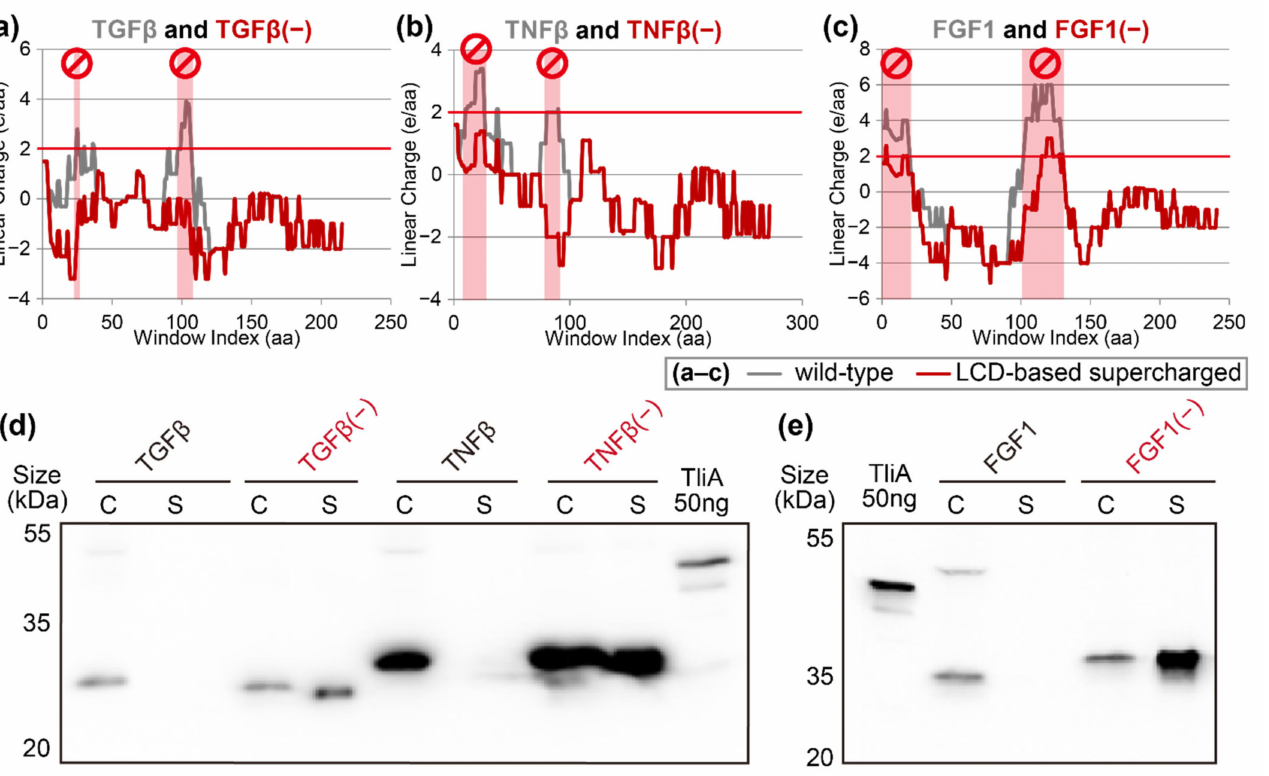
Figure 7. Linear charge density-focused supercharging significantly improves the secretion with minimal mutations. ( a – c ) LCD graphs of TGF β , TNF β , and FGF1 and their respective mutants. These mutants were designed by identifying >+2 peaks (red background) in the LCD graphs of native proteins (solid gray lines) and mutating positively charged solvent-exposed residues within those peaks. We only mutated residues with low ConSurf Bayesian conservation scores (<4). We also looked upon the homologs of the query protein and saw which amino acids were frequently occurring in that position, to select the replacement among anionic amino acids and neutral hydrophilic amino acids. Highly conserved amino acids (conservation score > 6) remained unmutated in all situations. In addition, the amino acids located in the ligand-receptor binding sites were not mutated. ( d , e ) The resulting mutant proteins from panels ( a – c ) were introduced into P. fluorescens cells and were tested via Western